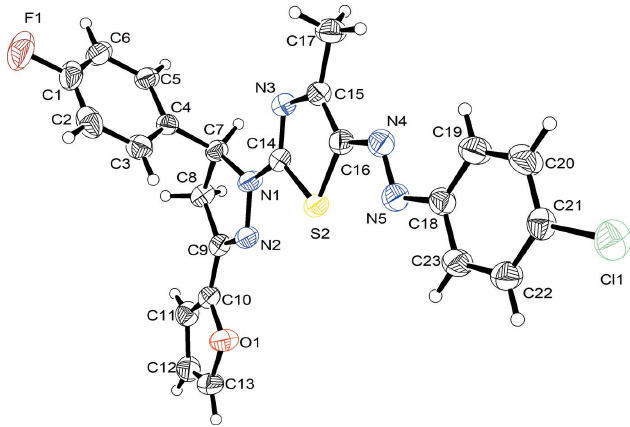
Figure 1 The molecular structure of the title compound showing 50% displace- ment